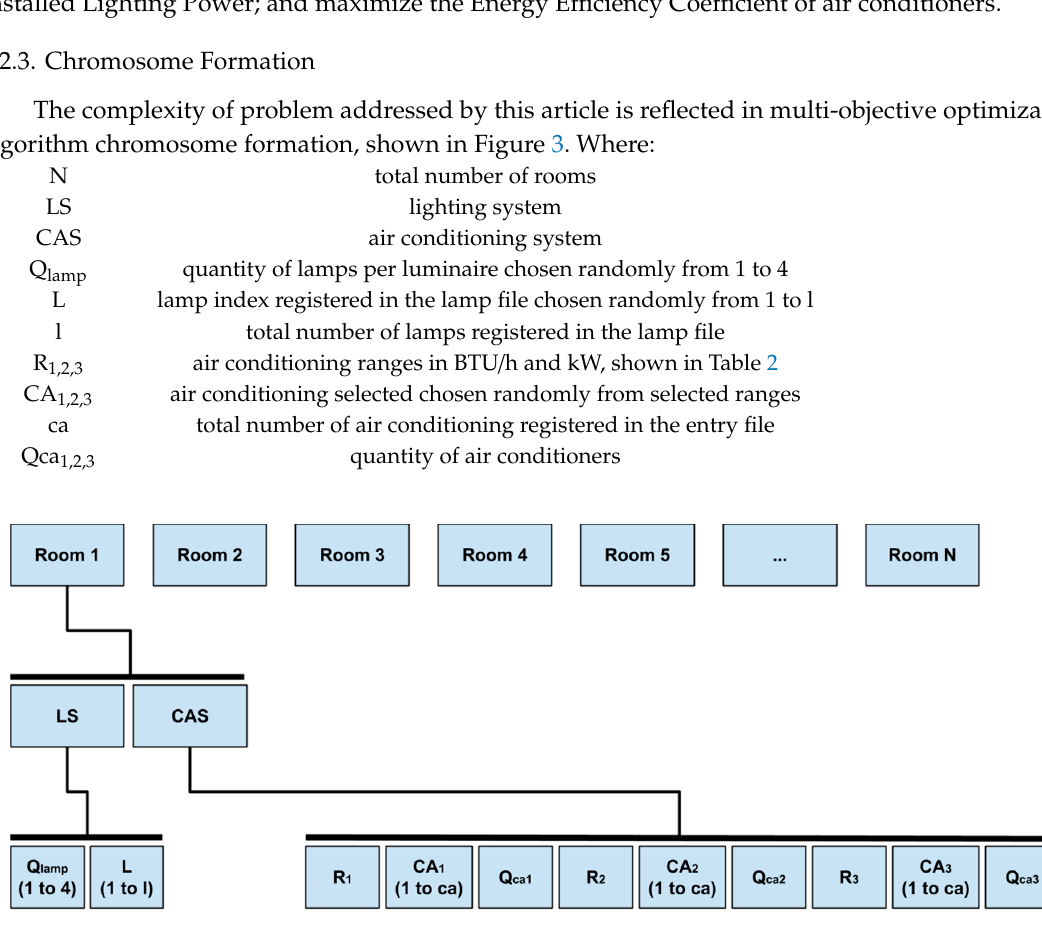
Figure 3. Chromosome developed to address the problem. Table 2. Cooling capacity value ranges defined in the methodology.